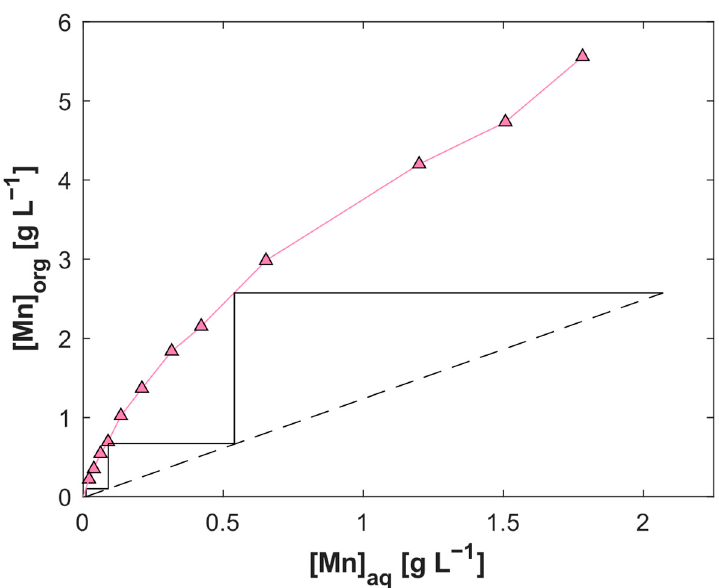
Figure 4. Effect of volumetric phase ratio on ( a ) metal concentrations in the organic phase and ( b ) the percentage of Li, Ni, Co, Mn, and Na extracted by 0.8 M D2EHPA (modified by 5 vol-% TBP and diluted in Exxsol D80). T = 25 ± 1 °C; pH = 2.5; t eq = 15 min. Initial aqueous concentrations [g L − 1 ]: Li: 2.63; Ni: 1.98; Co: 16.2; Mn: 2.07. Note the logarithmic O/A-axis.